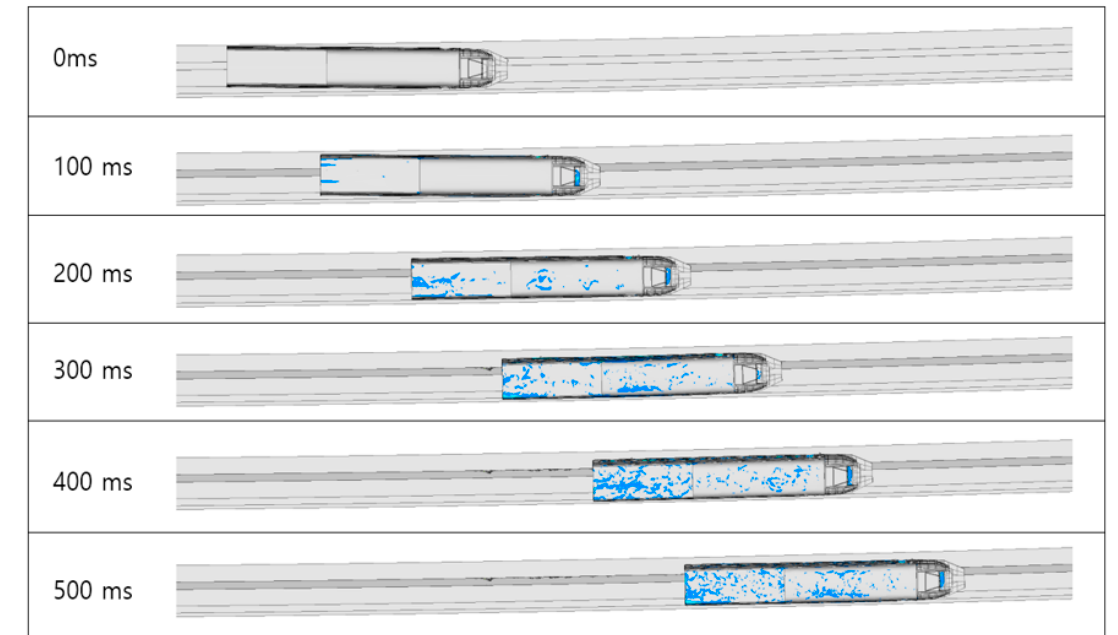
Figure 15. Collision behaviors of the vehicle (top view) [R3500, 300